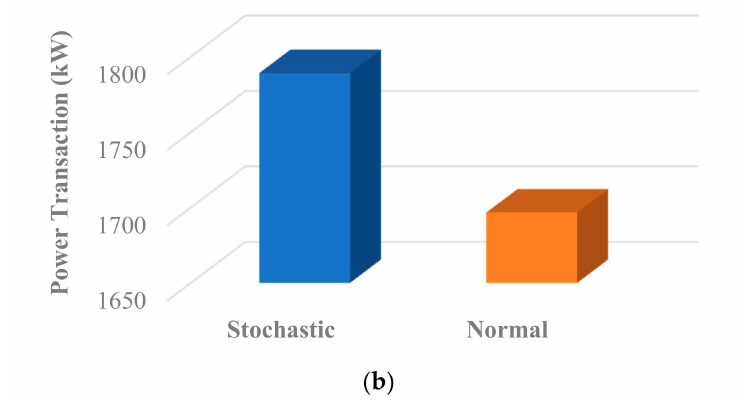
Figure 17. The comparison of power exchange: ( a ) the power transaction in 24 h, ( b ) cumulative changes across 24 h.